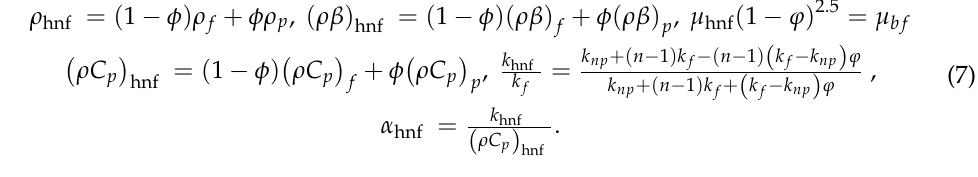
Table 1. Nanoparticles and base fluid thermo-physical properties as per Bendrer et al. [23]. Pure Water Mwcnt ρ (kg/m 3 ) 997.1 2100